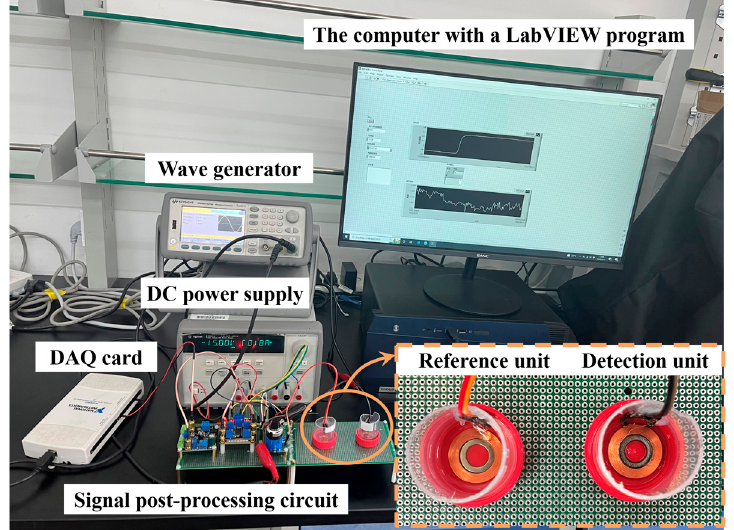
Figure 6. Photo of the detection system.